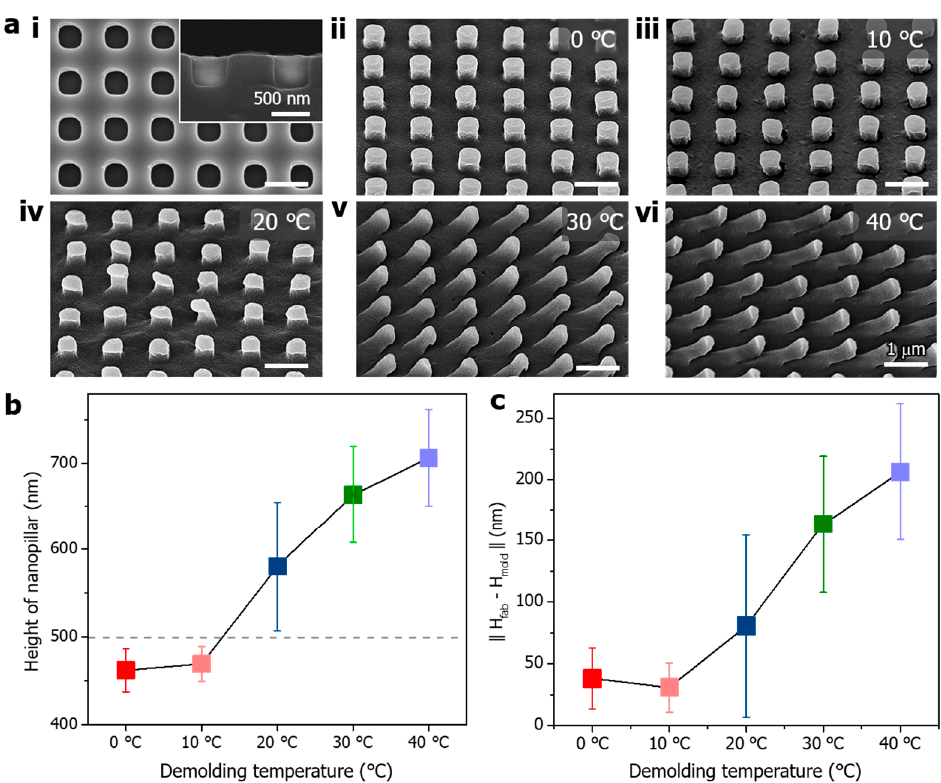
Figure 2. ( a ) SEM images: ( i ) negative-type PUA nanopillar mold surface; PCL nanopillars detached from the mold at ( ii ) 0 °C, ( iii ) 10 °C, ( iv ) 20 °C, ( v ) 30 °C, and ( vi ) 40 °C; ( b ) height of the nanopillar with respect to the demolding temperature; and ( c ) height difference between the mold and fabricated nanopillar with respect to the demolding temperature.